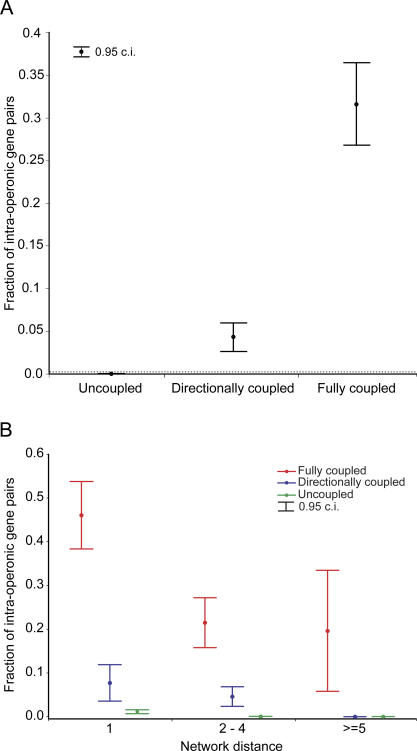
The Effect of Flux Coupling and Network Distance on Operonic Organization in E. coli
(A) The fraction of intra-operonic gene pairs correlates with the type of flux coupling. The dashed baseline indicates the fraction of intra-operonic gene pairs expected by chance.(B) The effect of flux coupling on the fraction of intra-operonic gene pairs in different network distance groups: χ2
d=1 = 715.3, χ2
d=2,3,4 = 5347.3, χ2
d≥5 = 5022.3, d.f. = 2, and p < 10−155.